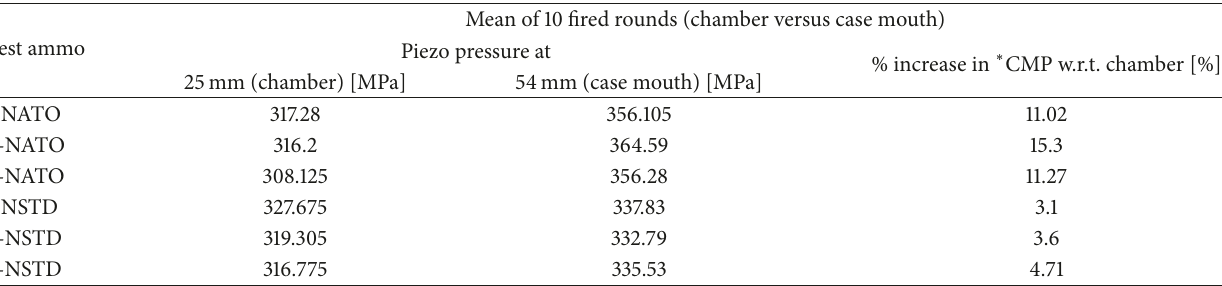
Table 6: Chamber pressure versus case mouth pressure.